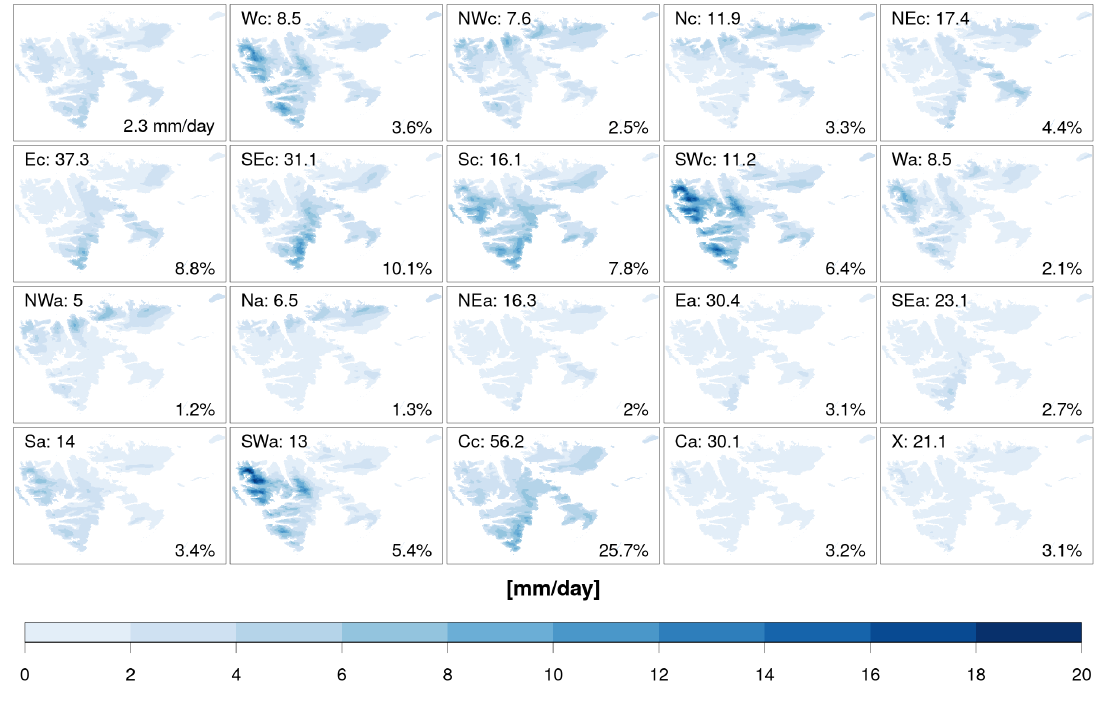
Figure 5. Annual mean precipitation (top left) from the MPI-ESM-LR driven COSMO-CLM current climate (1971–2000) simulation and its decomposition into single weather types over Svalbard. For the annual mean, the average daily precipitation over the whole land area is shown in the bottom right corner. For the different weather types, the contribution to the total precipitation is given in the bottom right corner, while the number in the top left corresponds to the number of occurrences per